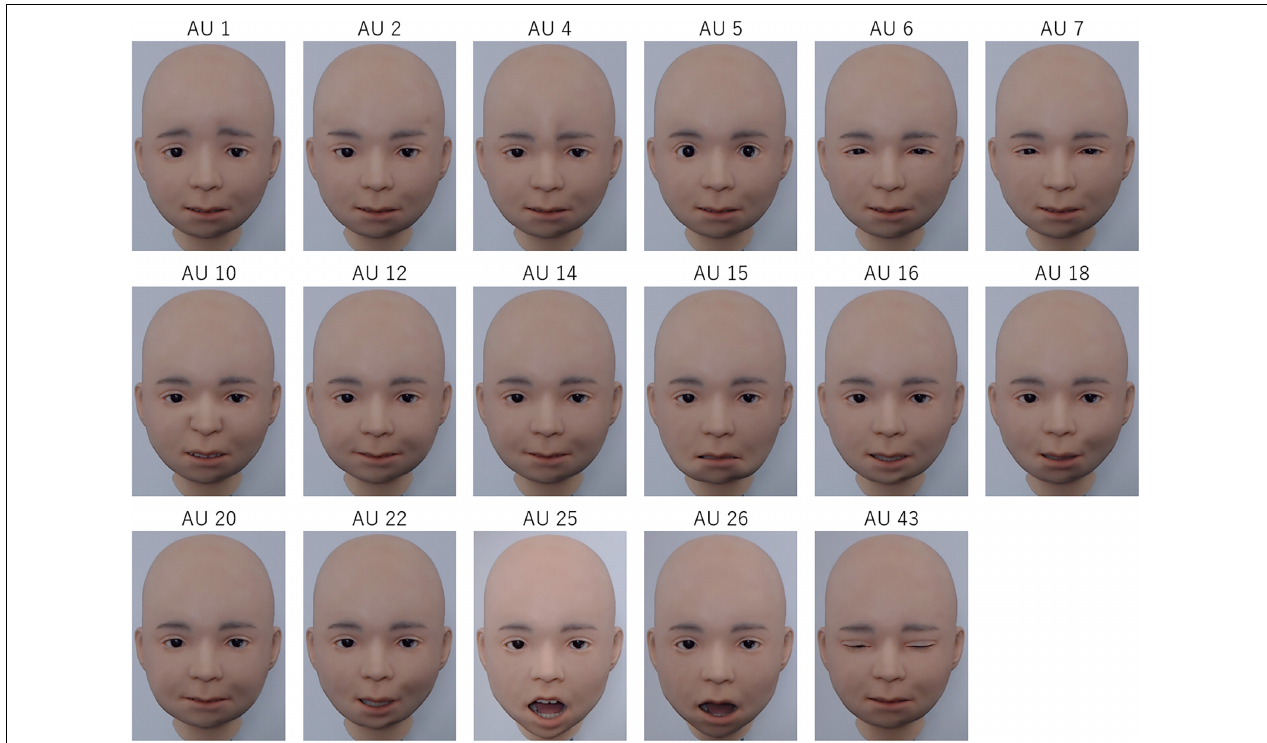
FIGURE 1 | Illustrations of the facial action units (AUs) produced by the android Nikola. For AU 25, AU 25 + 26 is